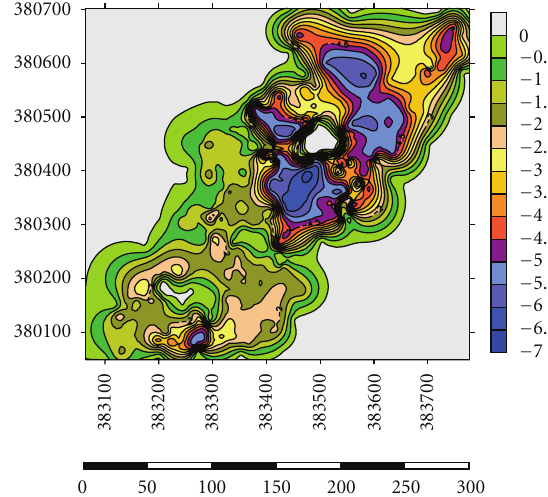
Figure 7: Showing depth at Lake C of the catchment.